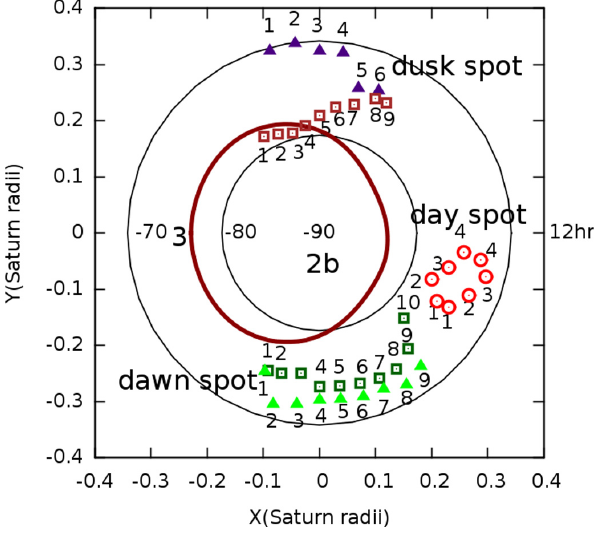
Fig. 12. Southern auroral boundary points for image C mapped into the northern ionosphere, in the same format as Fig.